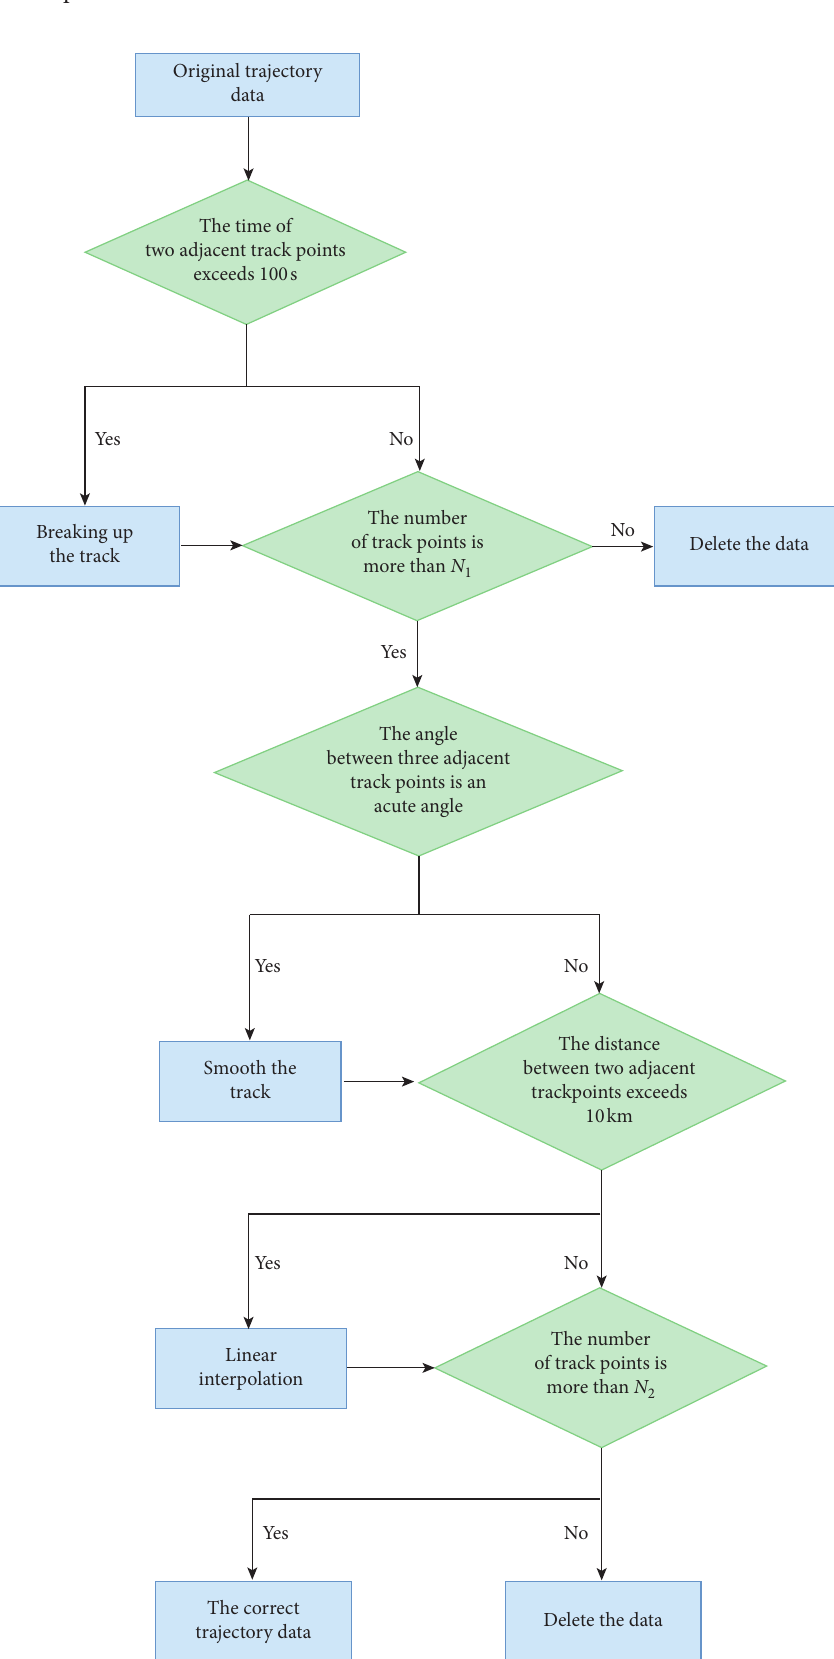
Figure 3: Wrong trajectory data processing algorithm